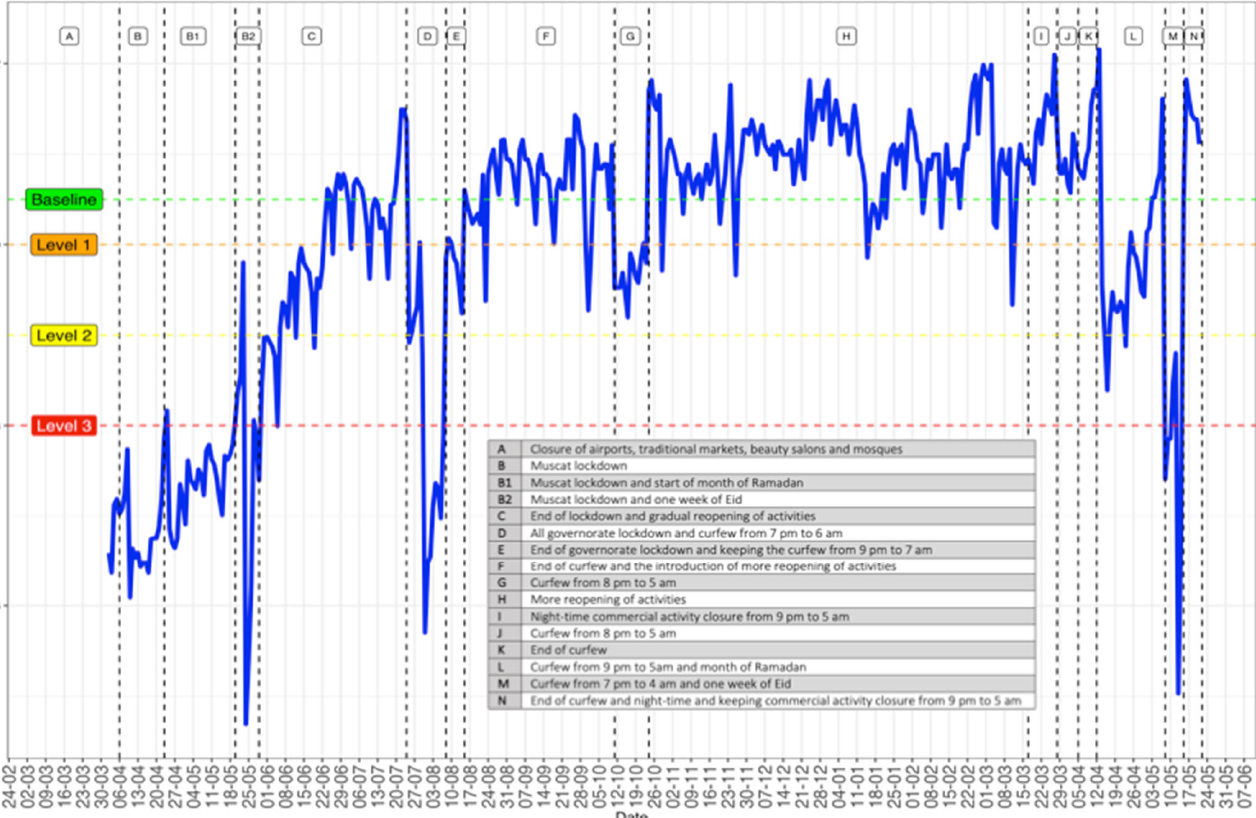
Figure 2. Omani government-mandated movement restriction NPIs, plotted against the CMI levels with an illustrative table of each mobility control measure. The weekly sharp troughs in the CMI line represent weekends and public holidays.